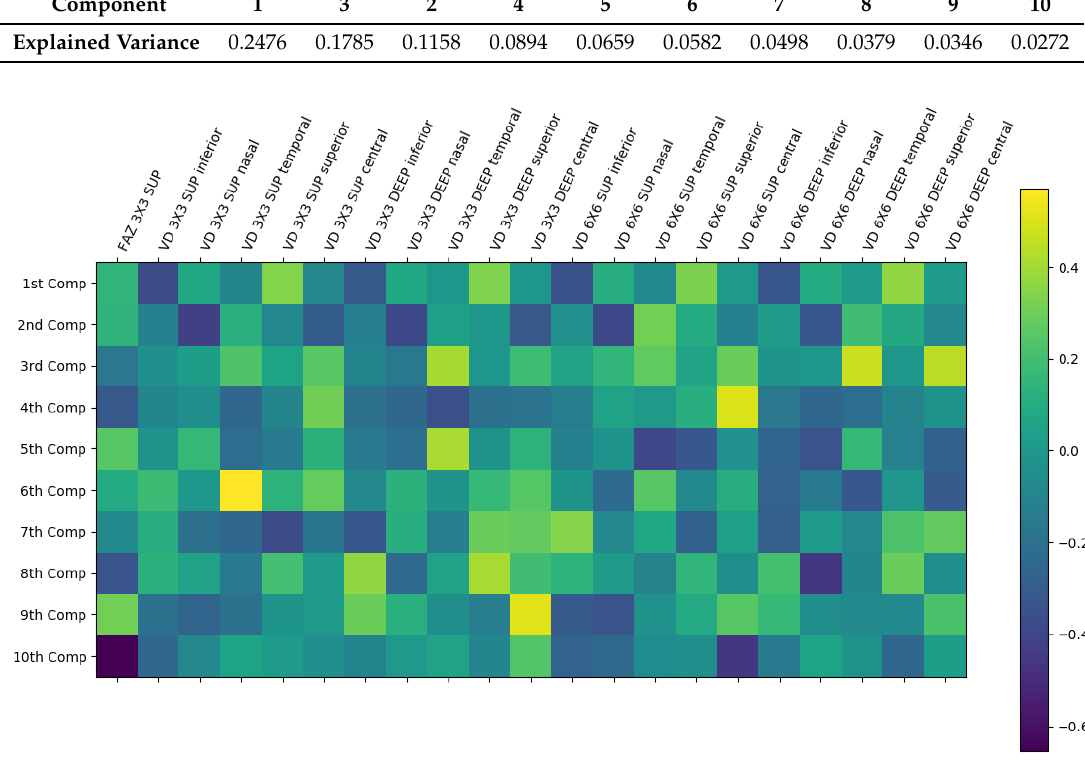
Figure 7. Representation of the significance of each input feature in the extracted Principal Components Analysis (PCA) components. The higher values (yellow cells) represent more significance whereas the smaller values (dark blue cells) represent less significance of the feature in the